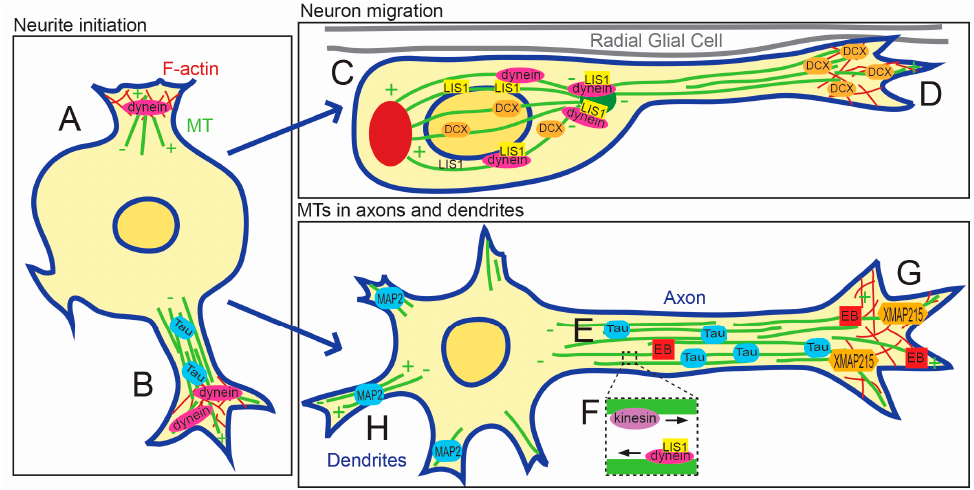
Figure 2. Overview of microtubule tasks during neuron maturation: ( A ) During neurite initiation, microtubules invade nascent lamellipodium; ( B ) microtubules form bundles to stabilize neurites; ( C ) microtubules form a perinuclear cage and provide force for nucleokinesis during neuronal migration; ( D ) in the migrating growth cone, microtubules stabilize and aid leading process growth; ( E ) polarized, bundled microtubules provide structural backbone of axon; ( F ) microtubules act as a transportation track for microtubule motors; ( G ) microtubules support axonal growth cone dynamics; and ( H ) microtubules of mixed polarity provide support to dendrites.